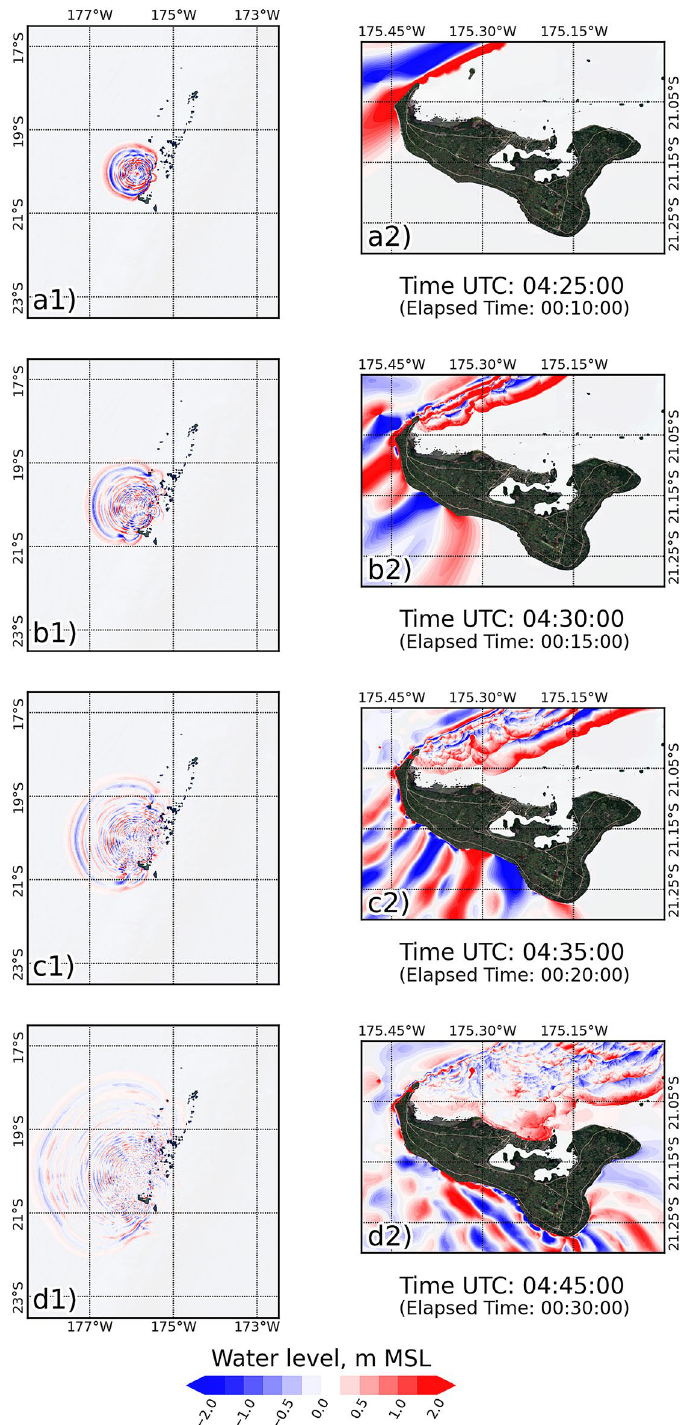
Figure 4. Tsunami propagation for the scenario of 25 Mt with the deep sea depth condition, showing the largest region in the 1st column and the smallest region in 2nd column: ( a ) 10 min, ( b ) 20 min, ( c ) 25 min, and ( d ) 30 min. The maps were created with a QGIS software 11 , version 3.16.15-Hannover (http:// www. qgis. org), and the satellite image for basemap was downloaded from QuickMapServices plugin (https:// github. com/ nextg is/ quick mapse rvices) through the QGIS 11